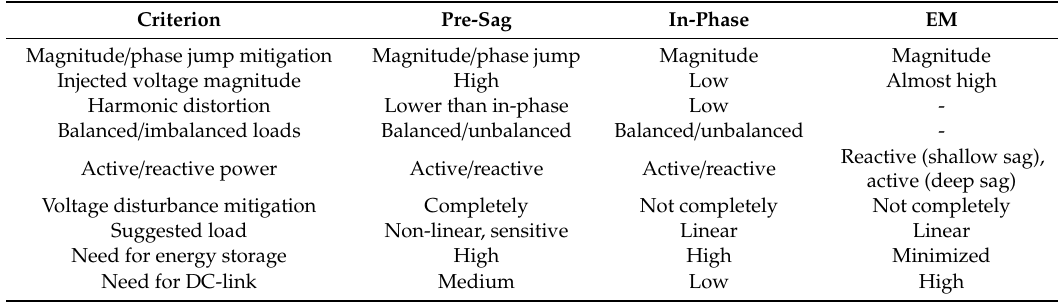
Table 8. Comparison of di ff erent voltage compensation methods. Based on data from [126–129].